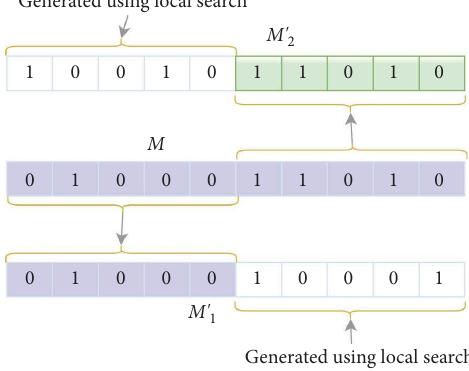
Figure 6: Illustration of